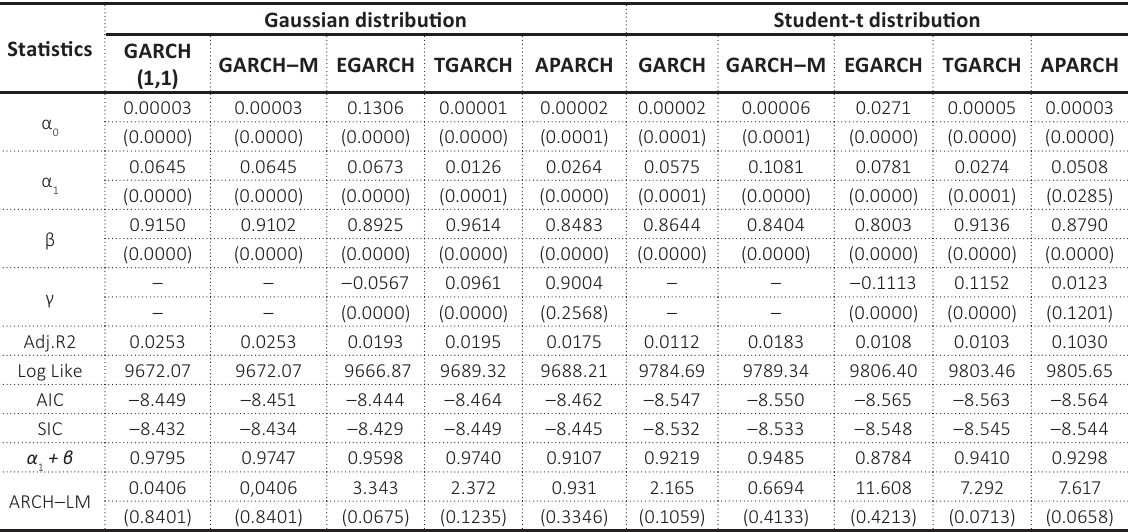
Table 8. Estimation result of GARCH models: INR/USD